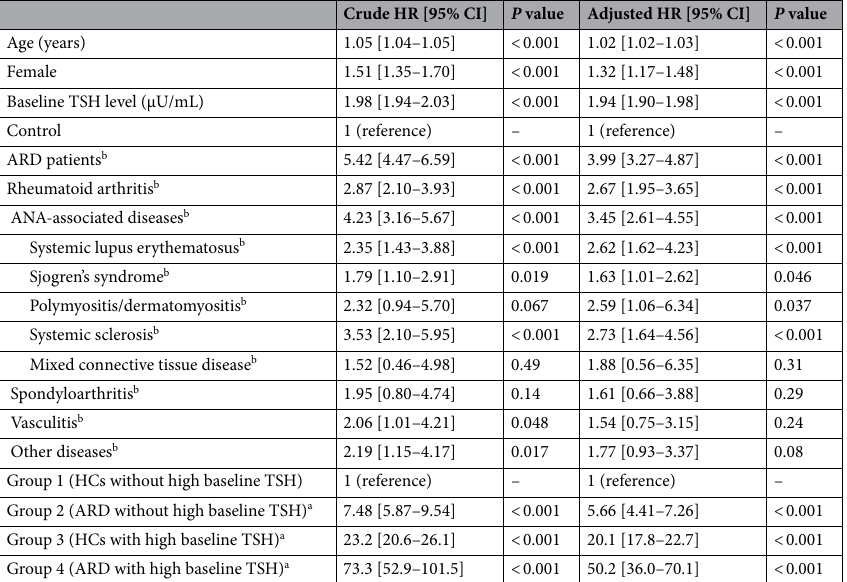
Table 3. Hazard ratio of autoimmune rheumatic diseases and baseline TSH for the development of hypothyroidism with treatment indication during follow-up. HR hazard ratio, CI confidence interval, TSH thyroid-stimulating hormone. a HR of each group was adjusted for age and sex in multivariate analysis. b Adjusted for age, sex and baseline TSH level in multivariate